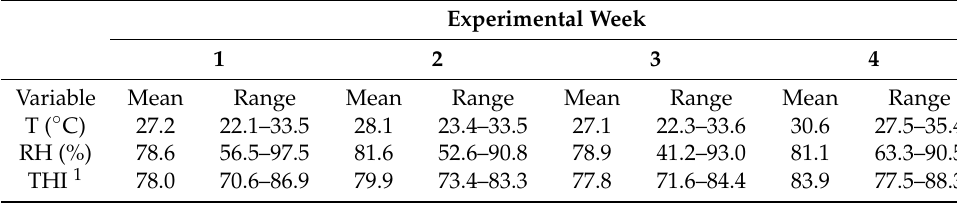
Table 2. Average and range weekly values for air temperature (T), relative humidity (RH), and temperature–humidity index (THI).